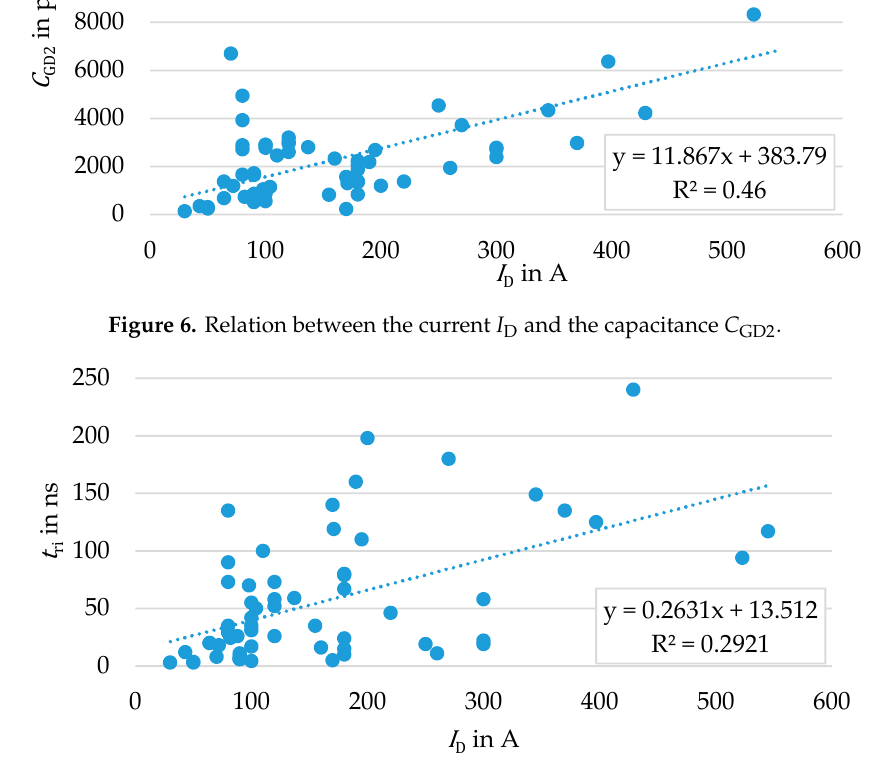
Figure 7. Relation between the current I D and the rise-time t ri